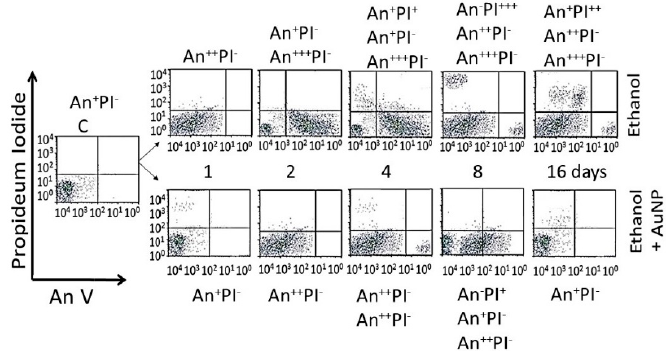
Figure 13. The time course of incorporation of annexin V and propidium iodide in An/En cells (C), Ap/En cells (bottom, 1 to 16 days, fixed AuNP dose of 20 mg/L), Ap/Ep cells (top, 1 to 16 days, fixed AuNP dose of 20 mg/L) and An/Ep cells (top day 1) cells. An: Annexin, PI: Propidium iodide, Superscripts: − within control range, + 10% to 15% increase, ++ >15% to 30% increase and +++ >30% increase.